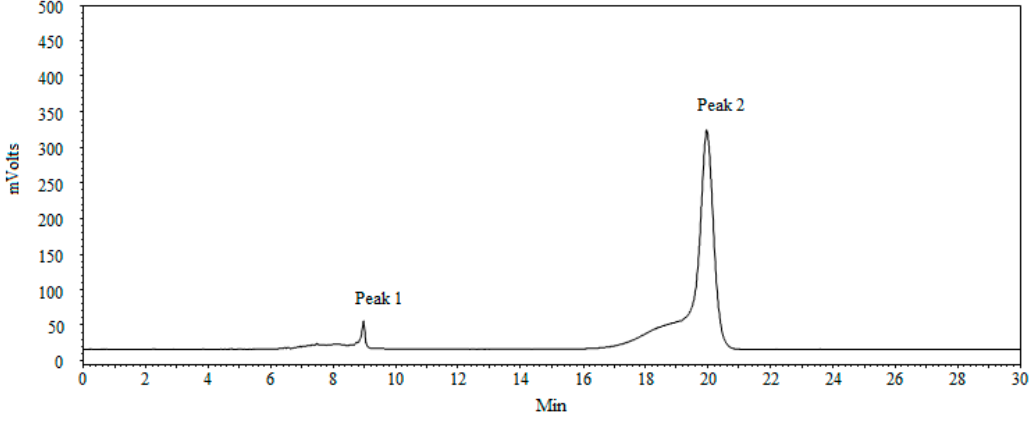
Figure 6. The HPGPC spectrum of PSA.